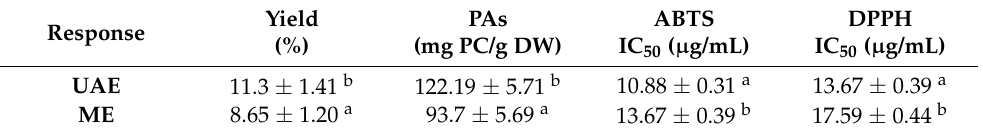
Table 3. Comparative yield, PAs, and chemical-based antioxidant activity of kiwifruit leaves by different extractions.